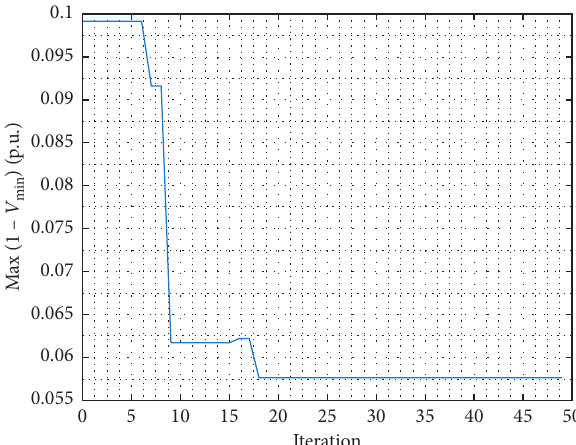
Figure 3: The convergence characteristic of voltage deviation for the 33-bus